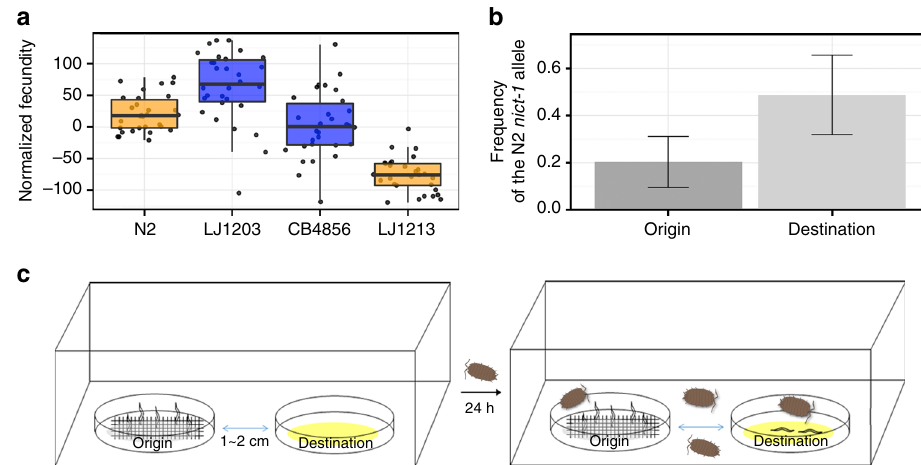
Fig. 3 The nict-1 QTL controls a fi tness trade-off and species dispersal on isopods. a Brood sizes of N2, CB4856, LJ1203 ( nict-1 CB4856 > N2), and LJ1213 ( nict-1 N2 > CB4856) are shown as Tukey box plots colored based on the nict-1 genotype. The horizontal line is the median, and the box denotes the 25th to 75th quantiles of the data. The vertical line represents the 1.5 interquartile range. All four strains were scored in 30 biological replicates, except for LJ1213 where only 29 biological replicates were scored. b The mean N2 nict-1 QTL allele frequencies before (origin) and after (destination) transmission competition assays are plotted. Error bars are standard deviations. c The experimental scheme of the transmission competition assay is shown. Transmission competition assay chambers contain two nematode culture plates. The “ origin ” plate contained a mixture of dauer animals from the CB4856 and LJ1213 ( nict-1 N2 > CB4856) strains and was covered with medical gauze to facilitate nictation. The “ destination ” plate was placed 1 – 2 cm away with no nematodes on this plate. Terrestrial isopods were added to the chamber and allowed to roam freely for 24h. Nematodes depend on the isopods for transfer to the “ destination ” plate from the “ origin ” plate because no transfer was observed without isopods presence. Eleven different biological replicates were